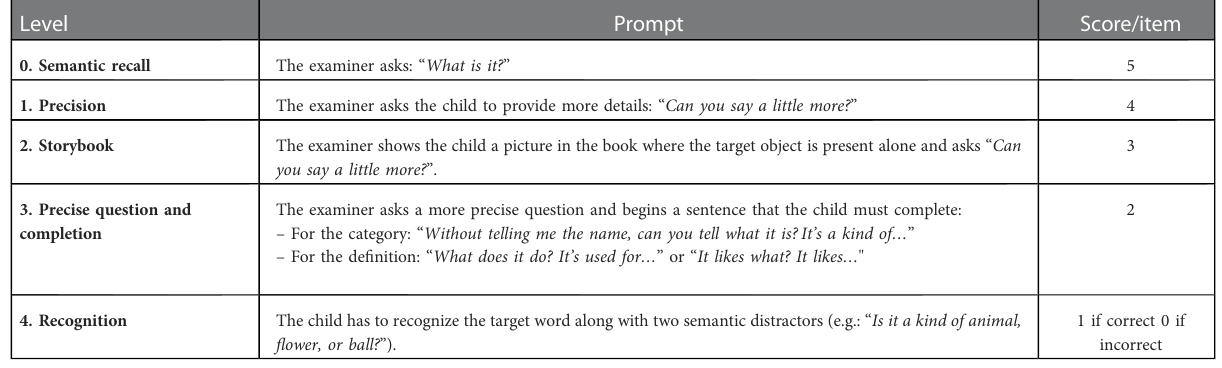
TABLE 4 Semantic recall: prompts and scores.